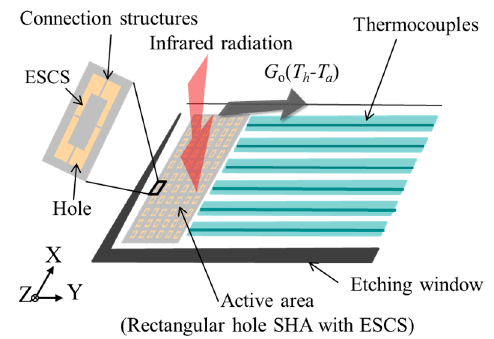
Figure 1. Sketch of the proposed CMOS compatible thermopile and heat conduction. SHA = subwavelength hole arrays, ESCS = extra subwavelength columnar structures.